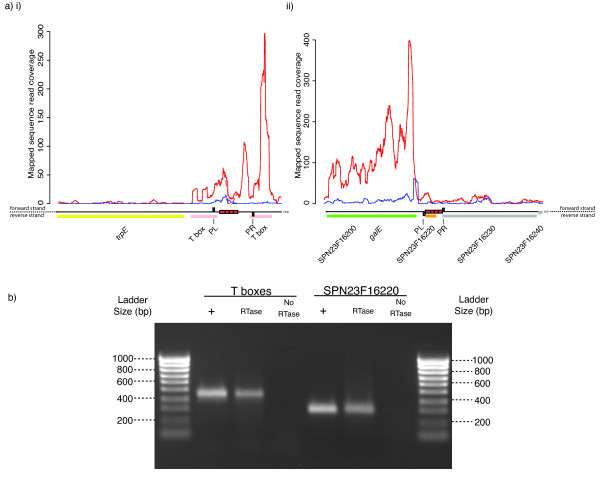
Repeat sequence expression congruent with genome annotation. a) All RNA-seq data is shown as plots of read coverage against the annotation of the represented genomic locus. Along the bottom of these panels, CDSs and non-coding RNAs, coloured according to function (see ref. [20]), are represented as blocks above or below the scale line, depending on their orientation. BOX repeats are shown as red blocks on the scale line. Primer binding sites are indicated by blue blocks labelled using dashed lines. Above the annotation, as part of the coverage plots, blue lines indicate transcription of the upper strand of the genome, while red lines show transcription of the reverse strand. Solid lines represent the result of fully redundant mapping, where reads mapping to multiple sites on the chromosome are randomly distributed between them. Dashed lines represent locally redundant mapping, where reads that might map to regions outside the displayed locus are excluded from the graph (see Methods). i) The region upstream of the trp operon. The trpE gene is adjacent to two T box riboswitch motifs separated by an intervening BOX element, represented as four adjacent red boxes representing the A1B2C1 structure of the repeat. The RNA-seq data suggests the T box motifs and BOX element are cotranscribed as a composite element, repressing the transcription of the downstream biosynthetic operon. ii) Locus surrounding SPN23F16220. This small CDS is annotated as being encompassed by a BOX element. RNA-seq data suggested it was cotranscribed with SPN23F16230, present on the other side of the repeat relative to the more highly expressed galE gene. b) RT-PCR to confirm transcription of these BOX elements. The positions of the primers used in these reactions are indicated by the blue boxes labelled PL (left primer) and PR (right primer) in a) i) and ii). In each case, the three lanes correspond to a positive control reaction using a genomic DNA (+), a test using cDNA produced through reverse transcription of an RNA sample (RTase) and a negative control using a non-reverse transcribed RNA sample (No RTase). The bands indicate that these BOX elements are expressed, as suggested by the RNA-seq data.